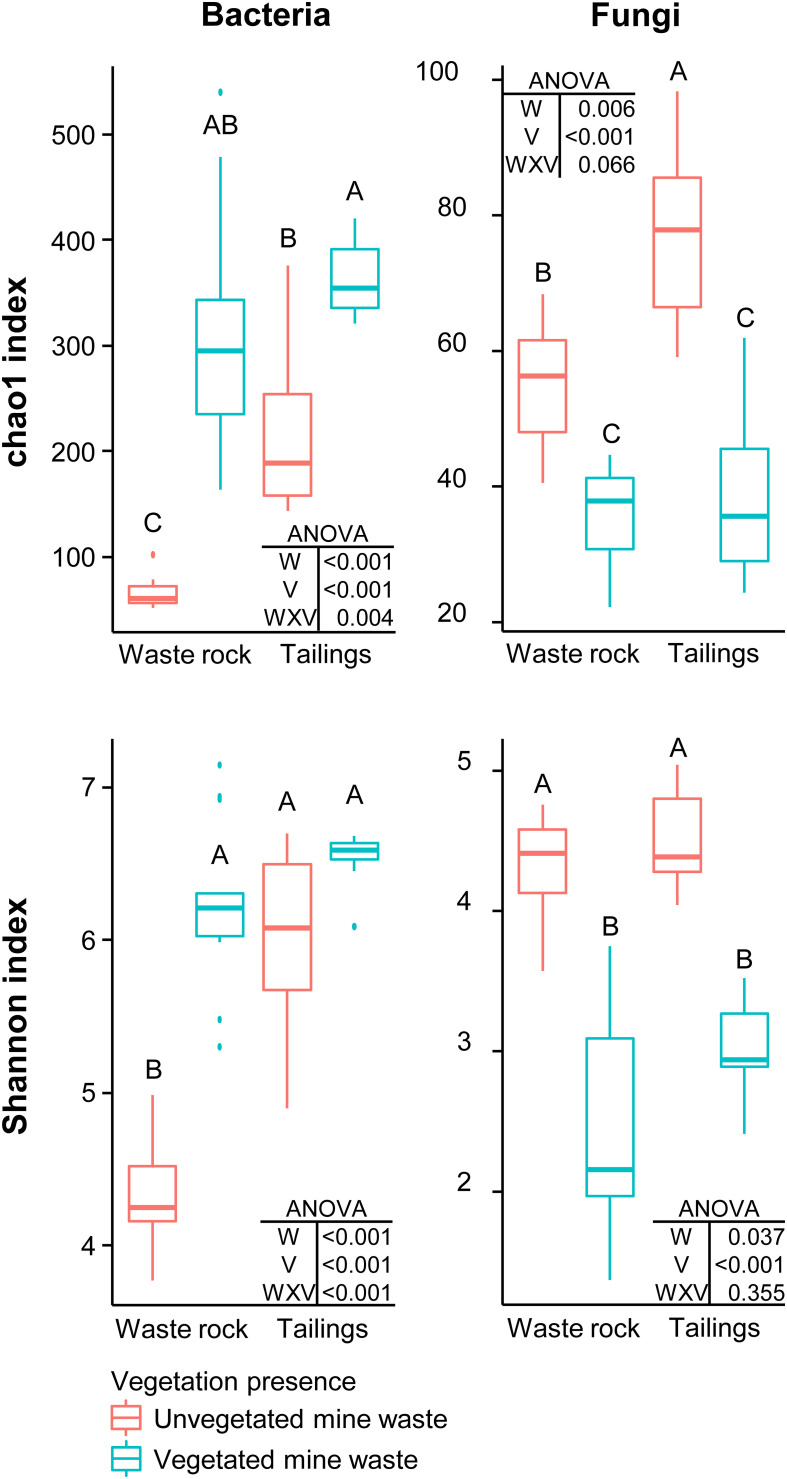
Alpha diversity indices of bacterial and fungal community profiles in field samples. A two-way ANOVA was used to discern how waste type, vegetation presence and their interaction influenced alpha diversity indices. In the ANOVA table, W is waste type; V is vegetation presence; and WXV is the interaction between waste type and vegetation presence. Treatments are composed of two factors: waste rock and tailings as waste type; and vegetated or unvegetated mine waste as vegetation presence. Shared letters between treatments means there is no significant difference between these treatments, as determined by Tukey HSD post hoc pairwise comparison test (n ≥ 8). Significance level is p < 0.05.